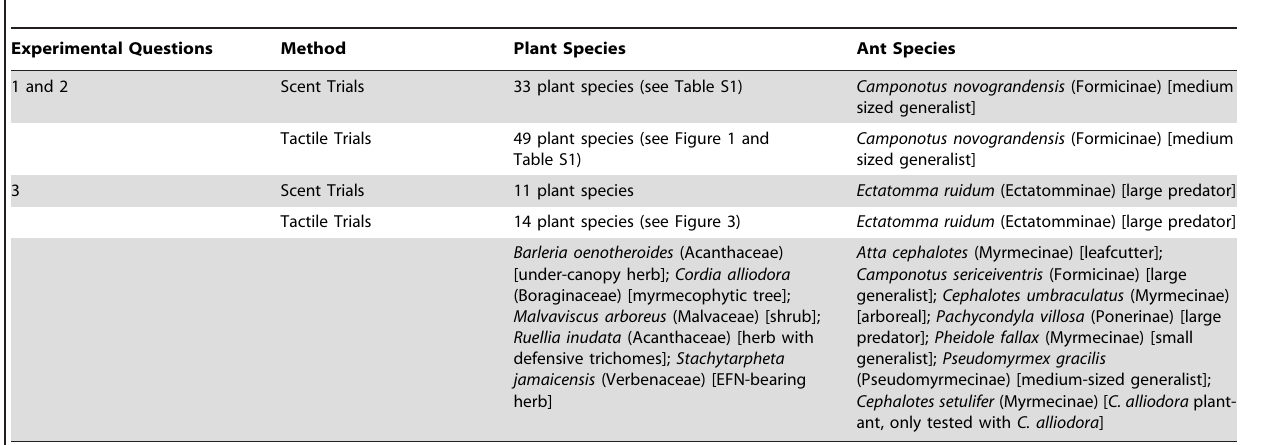
Table 1. Summary of behavioral trials carried out to address each experimental